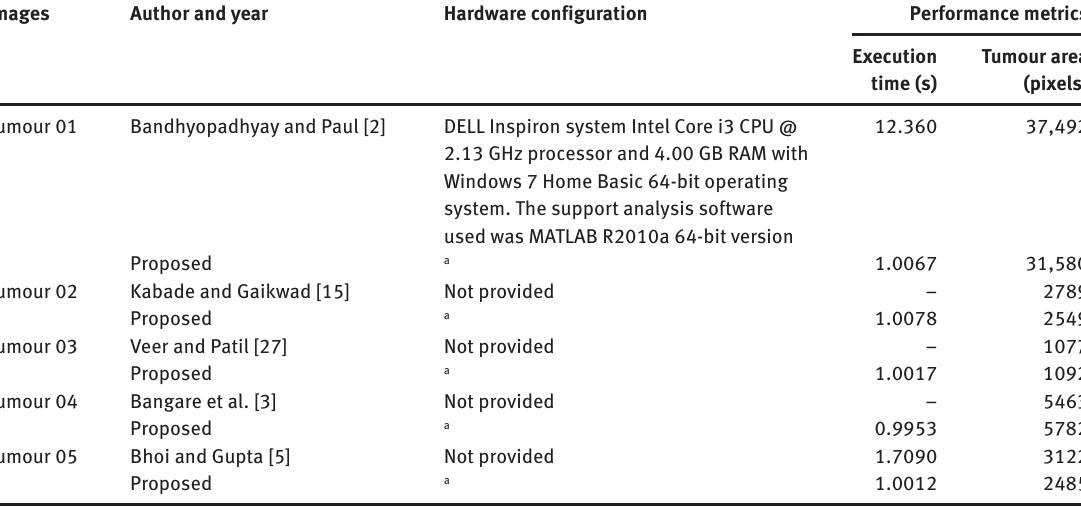
Table 8: Comparison of the Proposed Method with Some Recently Reported Methods in Terms of Execution Time and Tumour